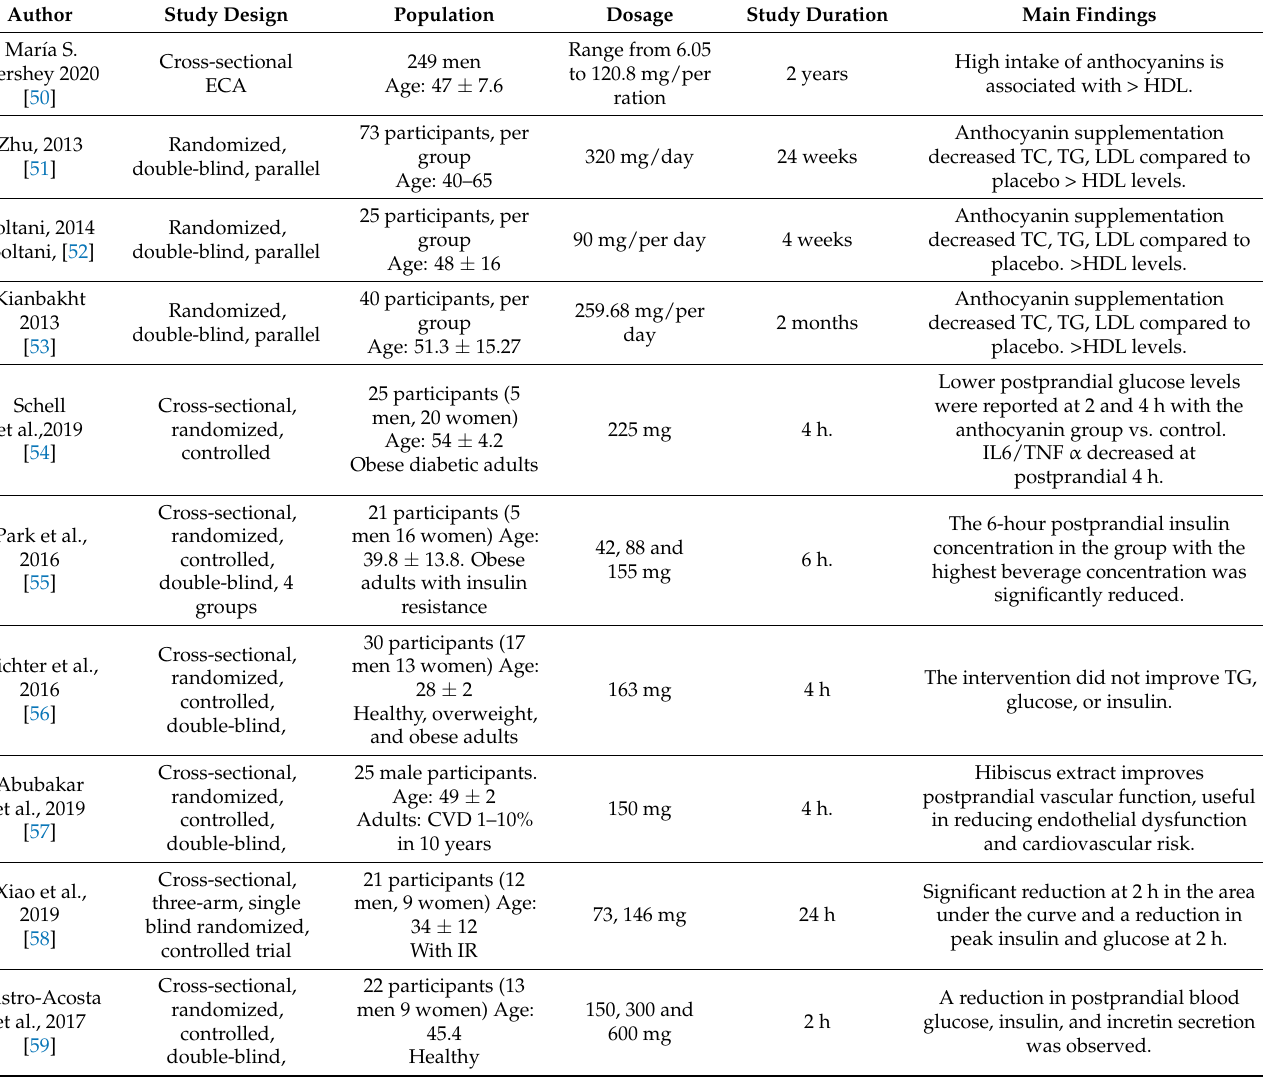
Table 1. Analysis of studies and dosage and discussion of evaluated clinical